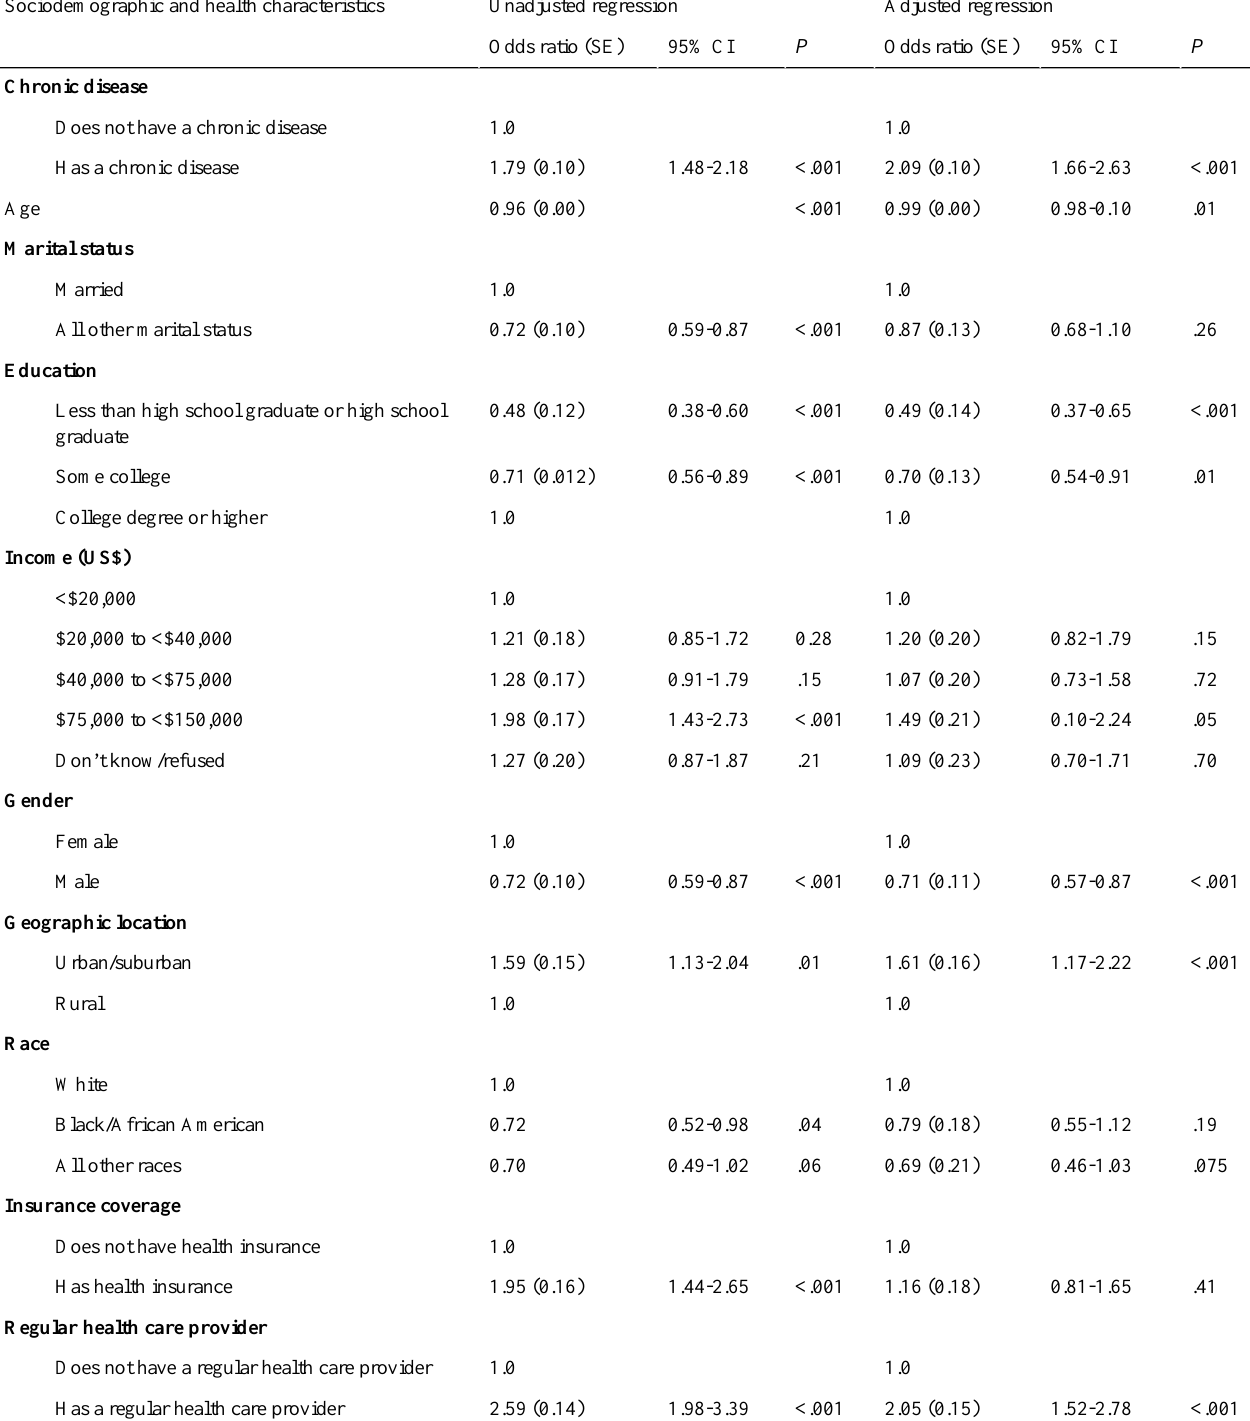
Adjusted regressionUnadjusted regressionSociodemographic and health